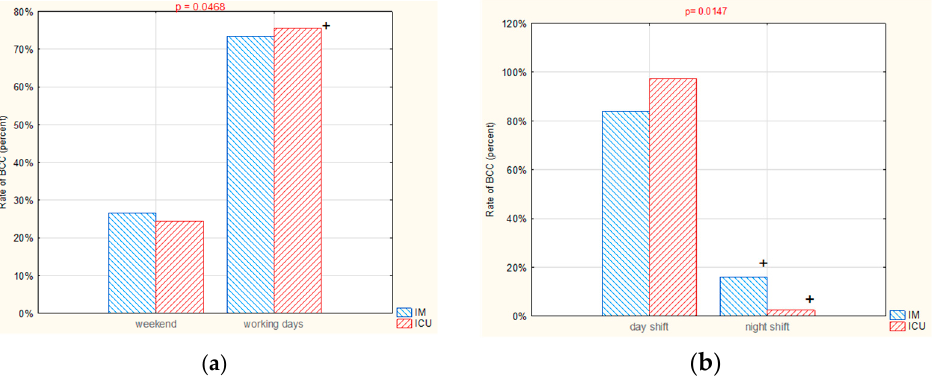
Figure 5. Rate of BCC on IM and ICU in 2019–2020 according to: ( a ) part of the week (working days vs. weekend), ( b ) type of shift (day vs. night). +: statistically